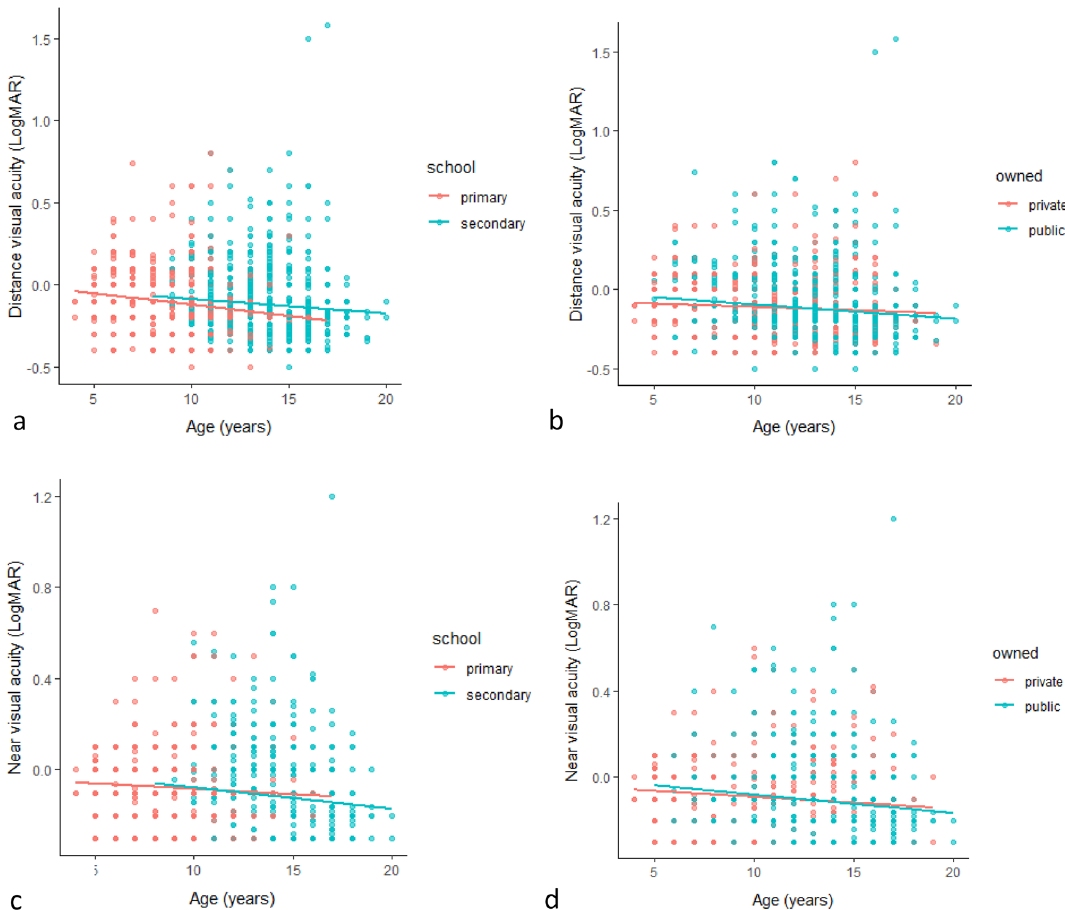
Figure 1. Distance and near VA as a function of age; classified into school types ( a and c ) and school ownership ( b and d